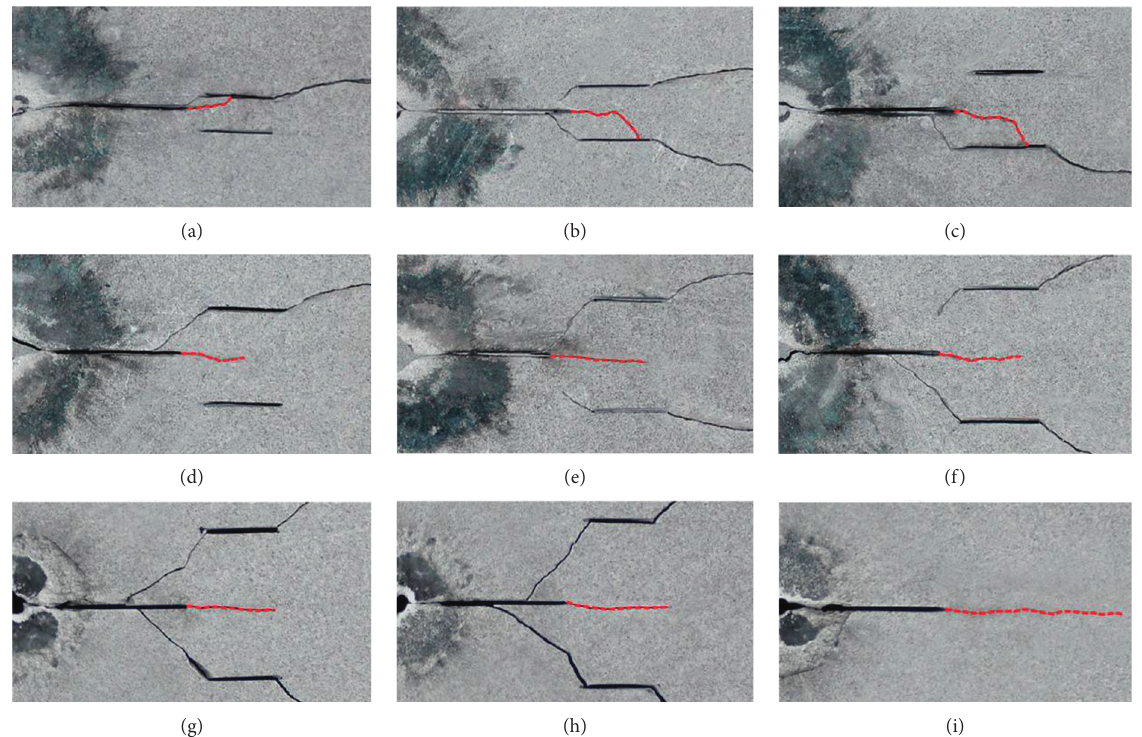
Figure 6: Crack propagation patterns under parallel symmetrical cracks in sandstone specimens. (a) S � 20mm. (b) S � 30mm.